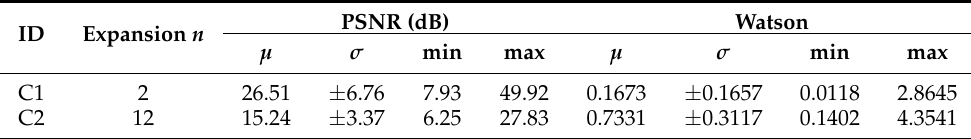
Table 4. Perceptual distortion performance of [35].